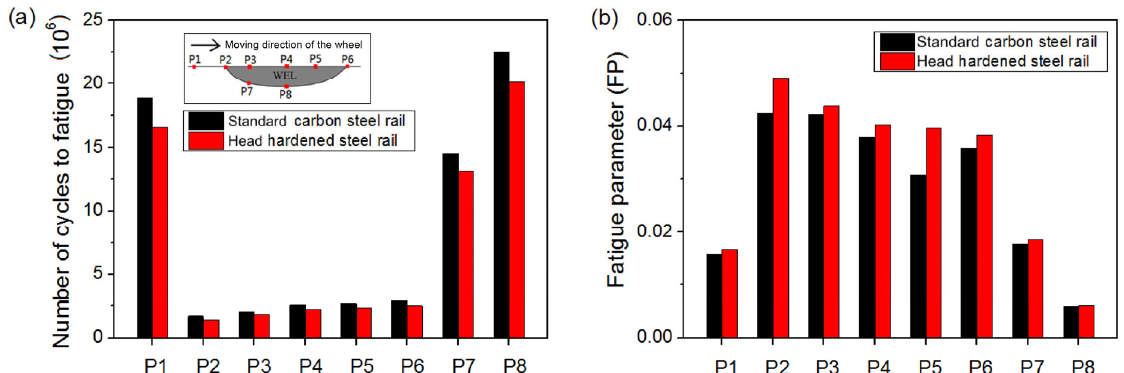
Fig. 11 Comparison of fatigue life at eight different positions between SC steel rail and head harden steel rail in terms of (a) number of cycles to N f and (b)